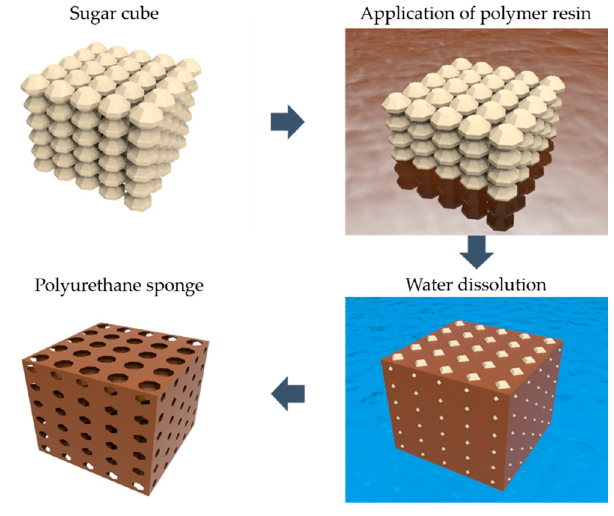
Figure 1. Fabrication of the polyurethane (PU) porous structure through the sugar templating process.